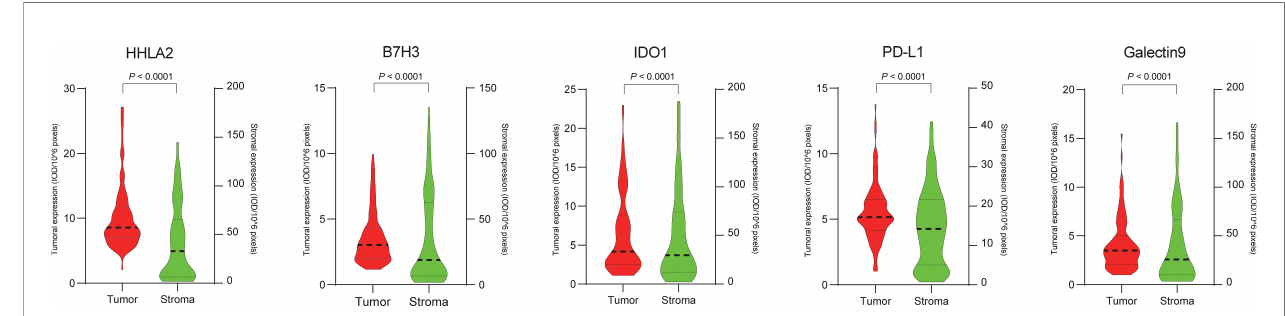
FIGURE 4 | Comparison of the expression levels of HHLA2, B7H3, IDO-1, PD-L1 and Galectin-9 between the tumoral and stromal compartments of